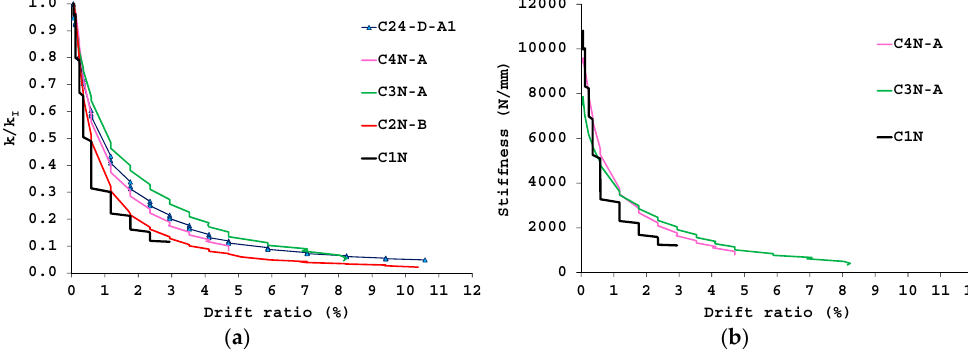
Figure 17. Stiffness degradation ( a ) and stiffness-drift ratio relationship ( b ) specimens subjected to ν = 0.40.